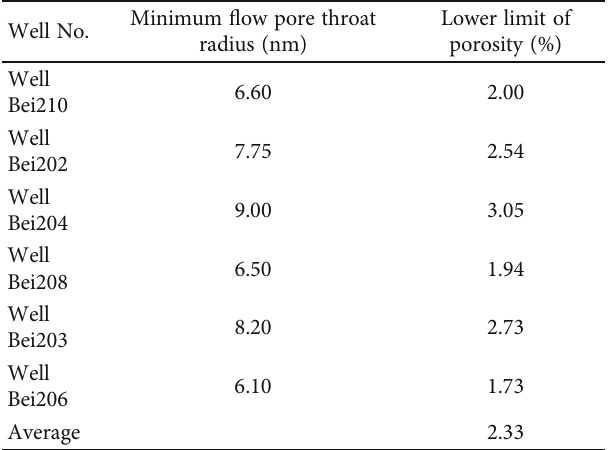
Table 3: Statistics of the lower limit of porosity obtained using the minimum fl ow pore throat radius